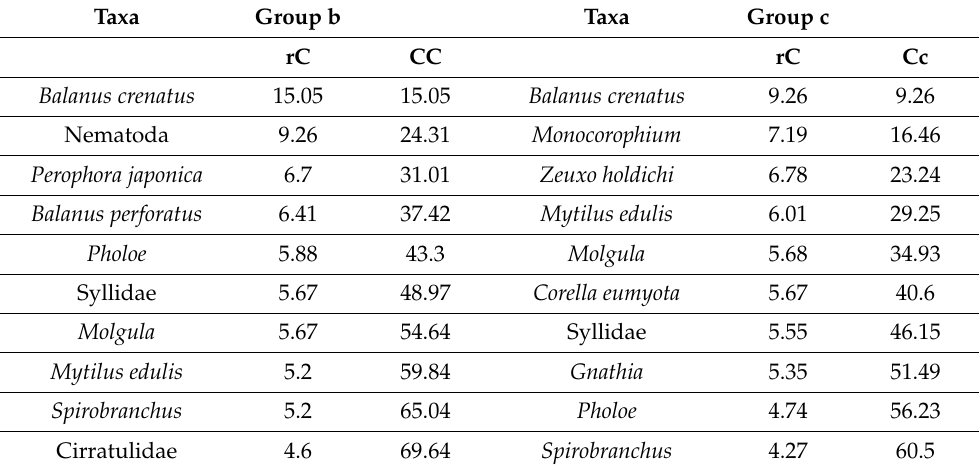
Table 6. SIMPER analyses with respective contribution (rC) and cumulative contribution (Cc in %) of the ten top taxa of the 2018 blocks (group b) and 2015-2017 blocks (group c).